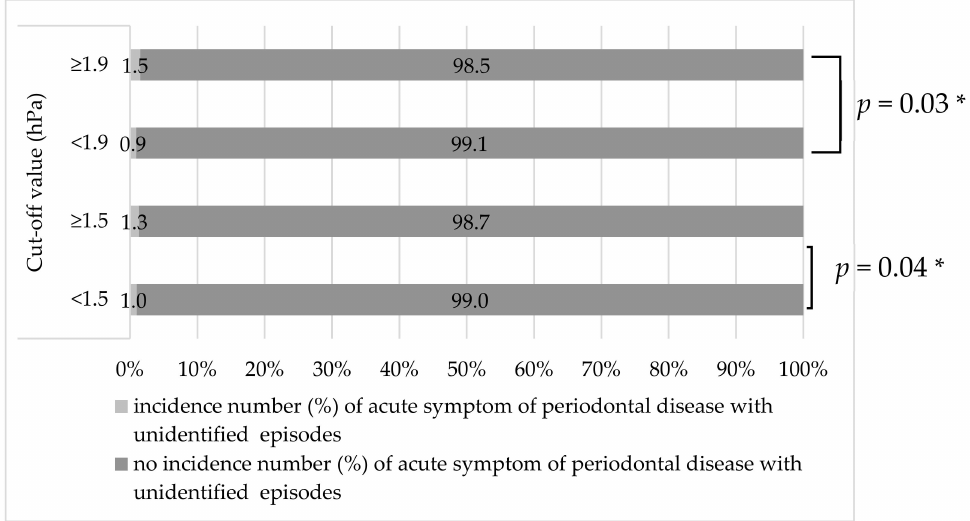
Figure 2. Evaluation of the two cut-o ff values of the maximum hourly decrease in barometric pressure to predict the incidence of the acute symptom of chronic periodontal disease. * Chi-squared